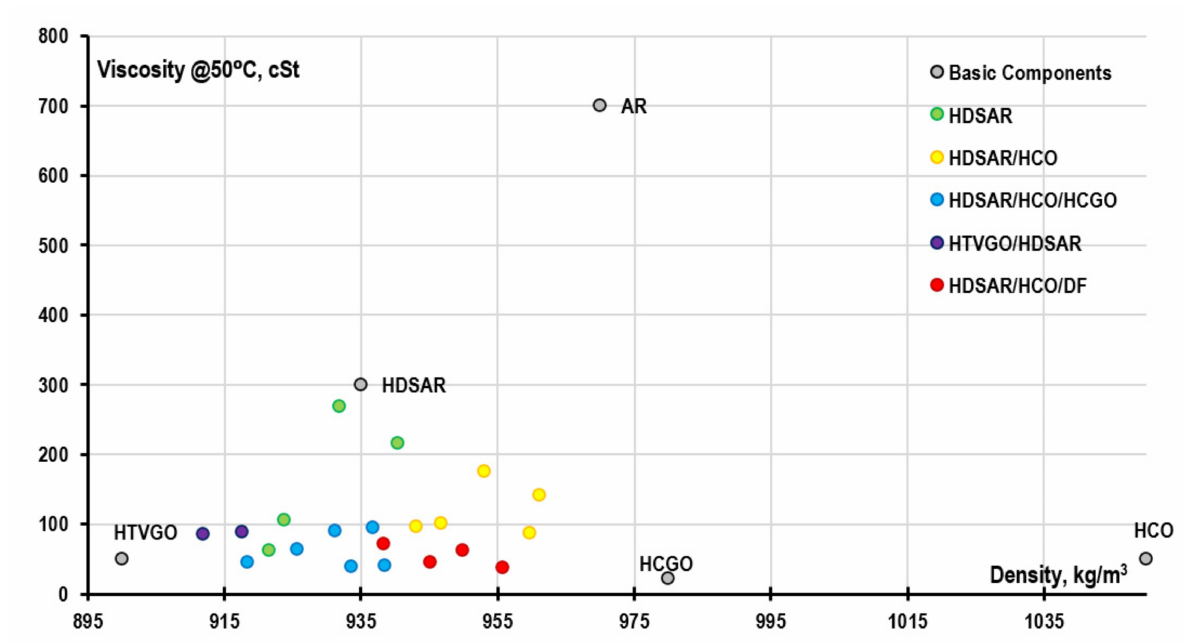
Figure 11. The most common types of fuel compositions in standard coordinates [60].